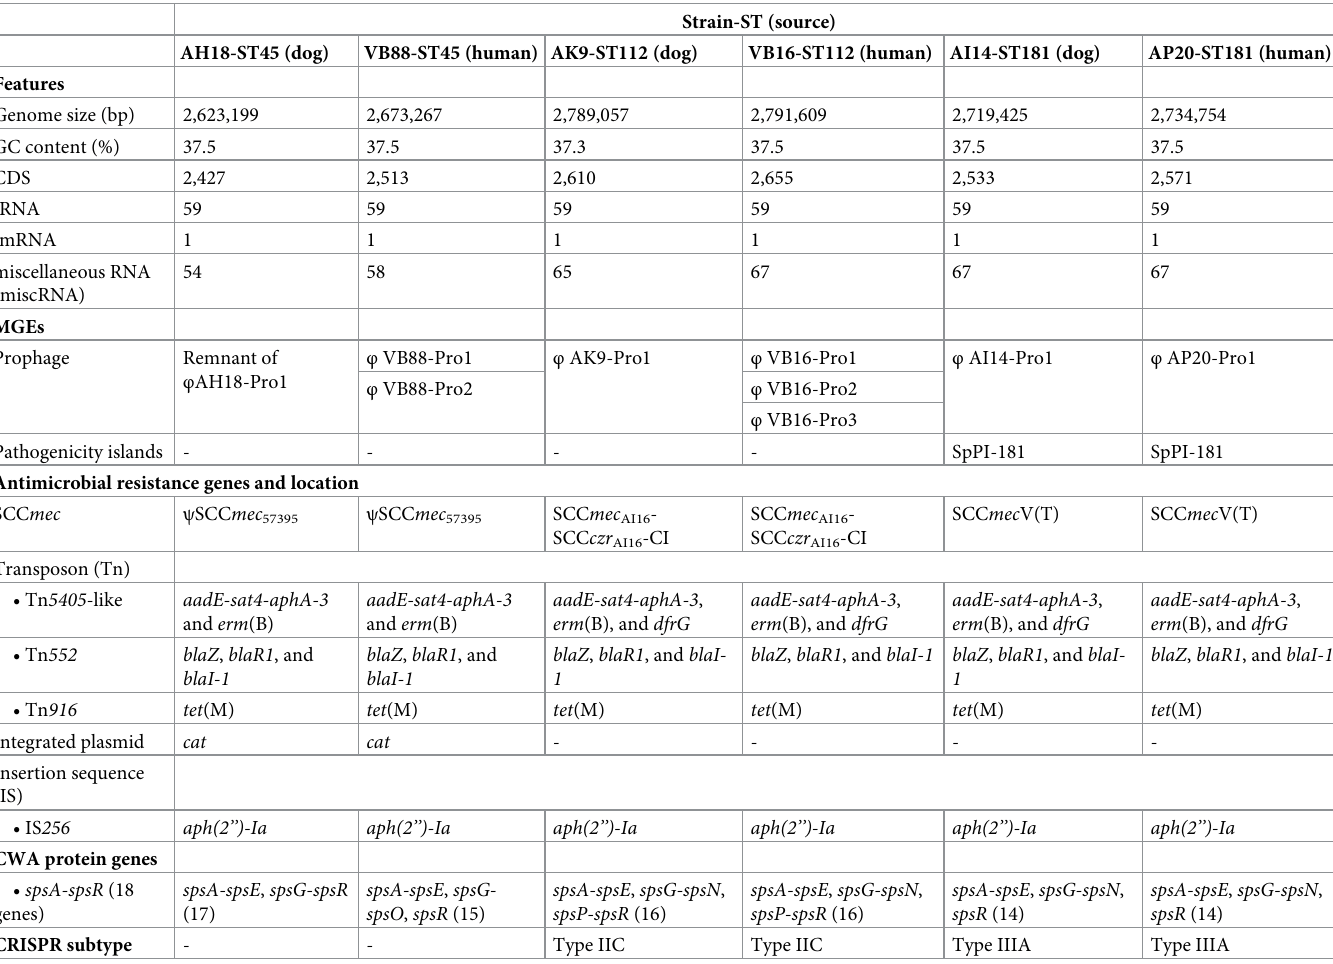
Table 1. General features, mobile genetic elements (MGEs), antimicrobial resistance associated with MGEs, CWA protein genes, and CRISPR of six representative MRSP